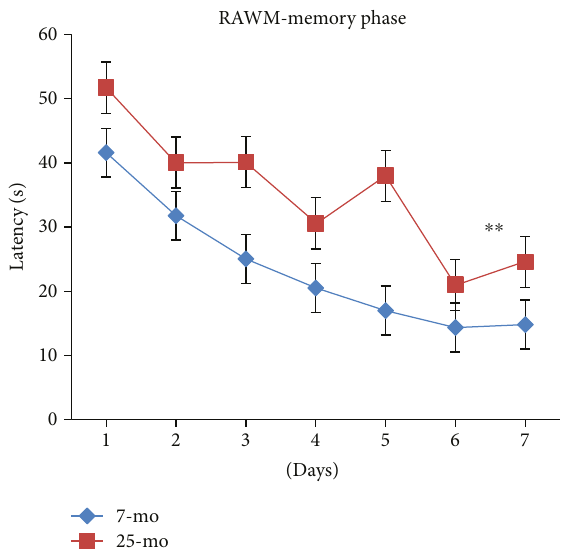
Figure 11: Latencies of 7- and 25-month-old C57BL/6 male and female mice in memory phase of RAWM (s, mean ±